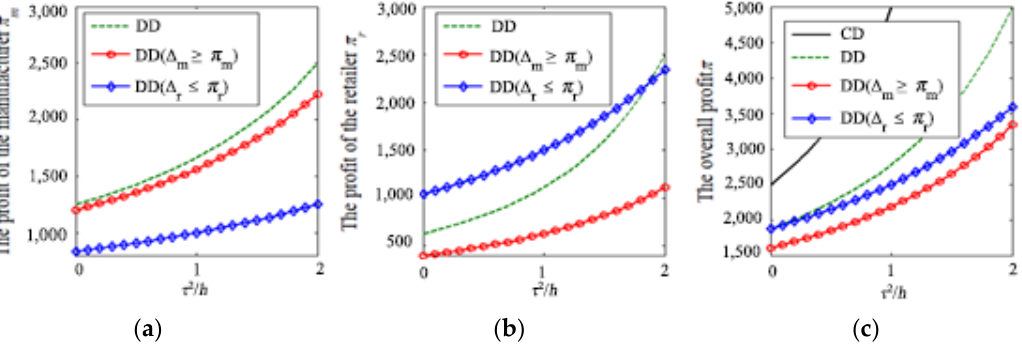
Figure 1. The effects of green efficiency coefficient of products (GECP) on decision variables.